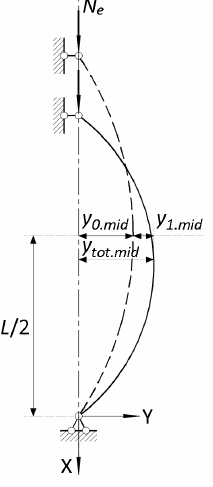
Figure 1. Column with initial imperfection.